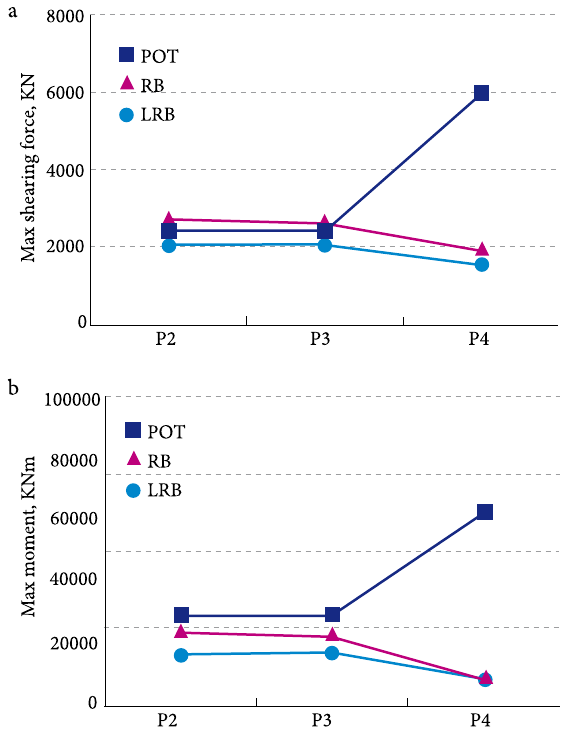
Fig. 7. Max shearing force (a) and max moment (b) in compari- son of sectional forces at each pier (response spectrum